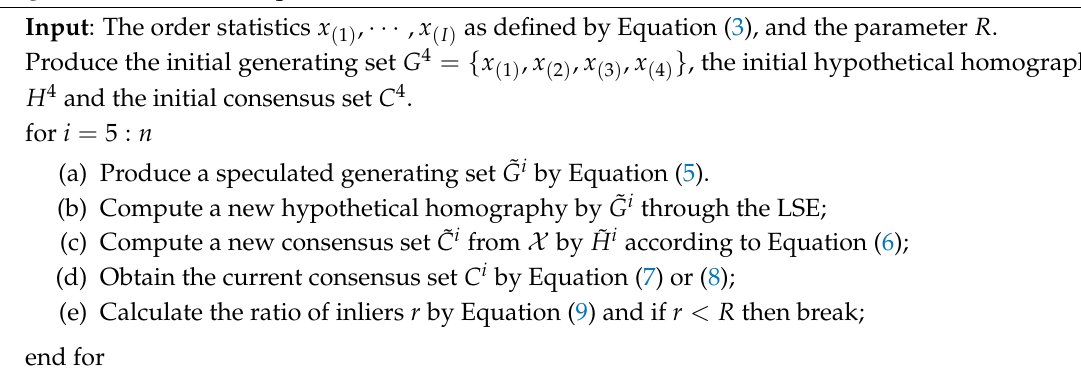
Algorithm 1 The Least Squares Consensus Estimation